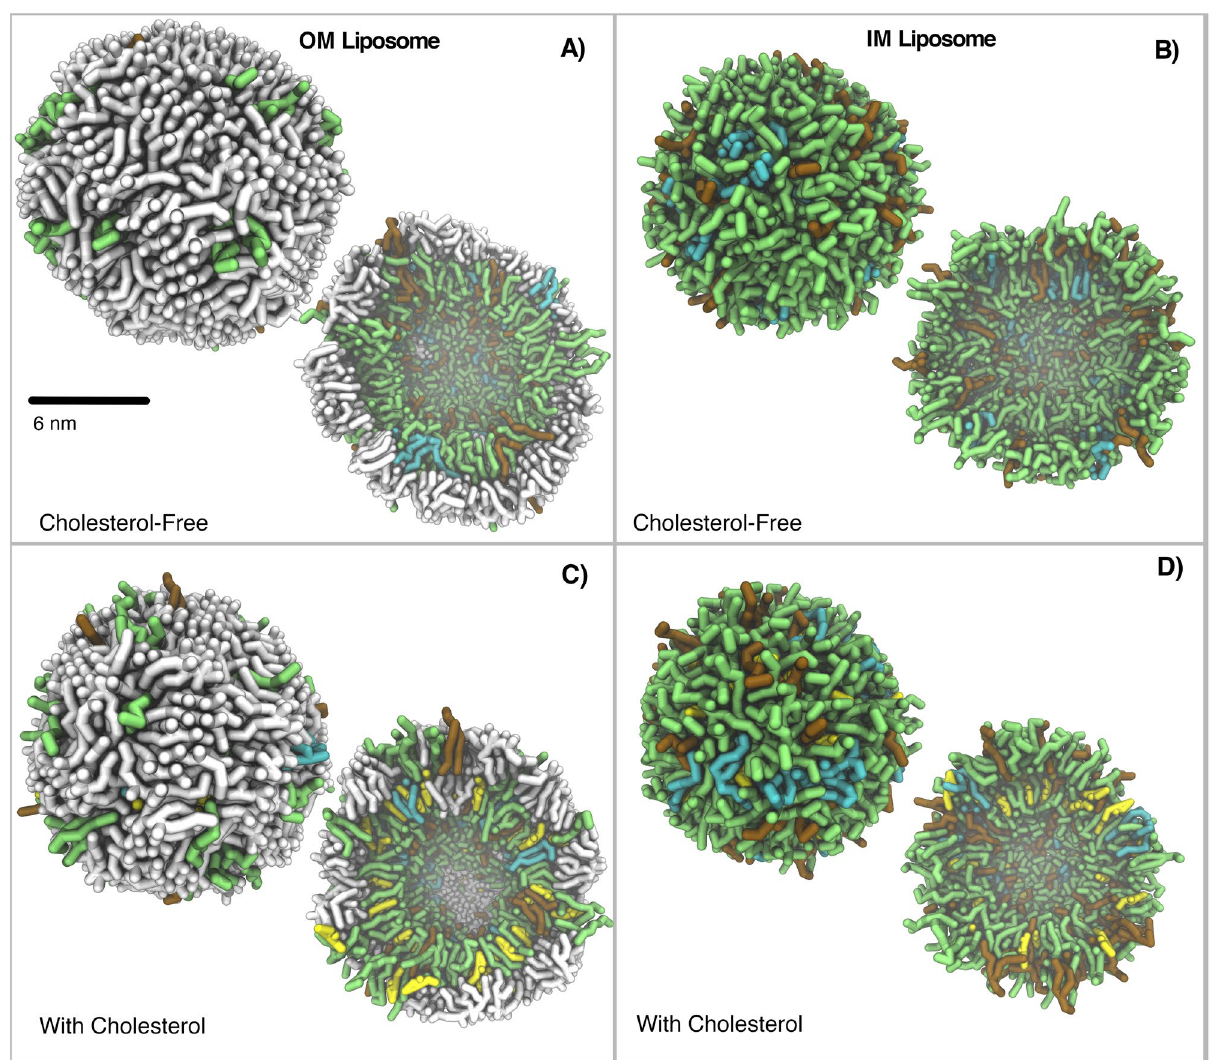
Figure 1. E. coli Liposome models. Cholesterol-free OM ( A ) and IM ( B ) liposomes respectively. With cholesterol ( C ) and ( D ) respectively. External view and a crossed-section view. Lipid A in white, Cholesterol in yellow, POPE in green, POPG in cyan and CDL in red. Water and Ca +2 beads are not included for clarification. 3D structures from last equilibrated